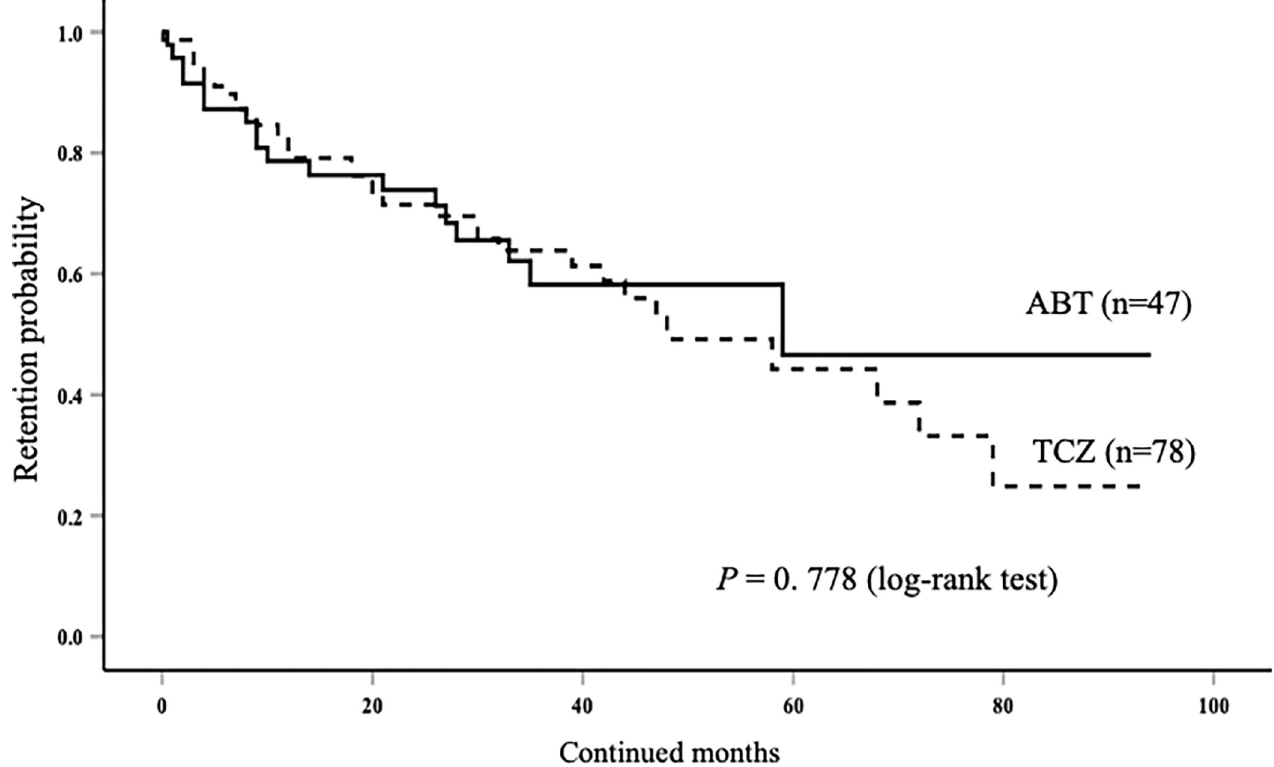
Fig 4. Kaplan–Meier curve related to the overall cumulative drug retention rate of ABT and TCZ in elderly patients initiating these bDMARDs. There was no significant between-group difference with respect to the drug retention rates.